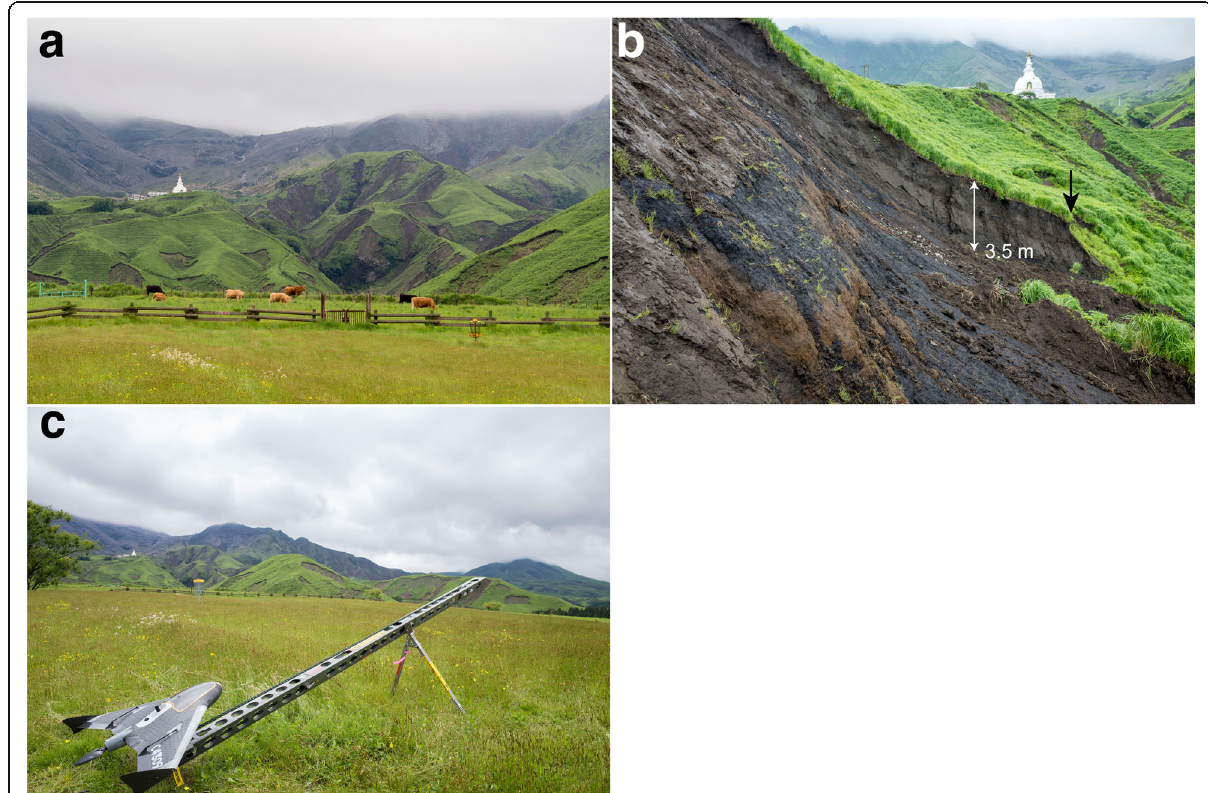
Fig. 2 Sensuikyo area following the 2016 Kumamoto earthquake. a Overview of the study area, b coseismic landslide scar and rainfall-induced landslide scarps (black arrow) described in Fig. 4, and c the investigation using Trimble